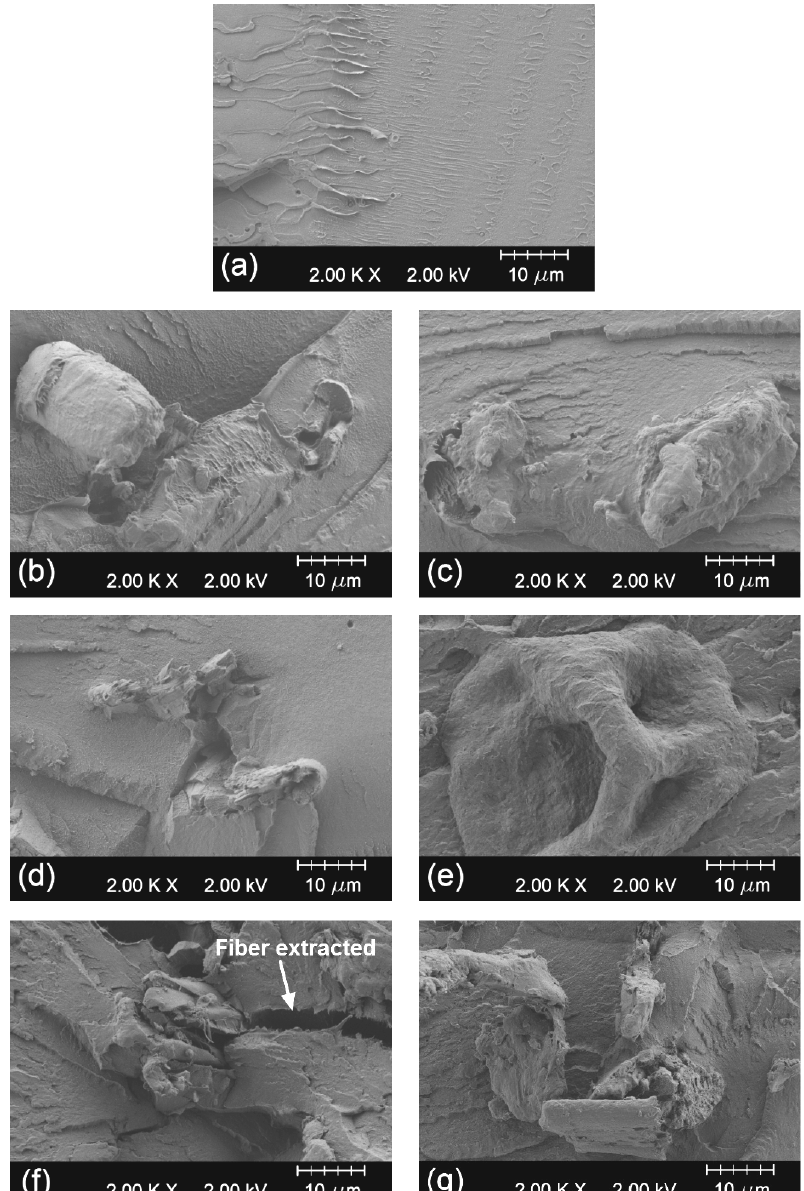
Figure 2. Field emission scanning electron microscopy (FESEM) images corresponding to the surface fractures of the bio-based polyethylene terephthalate (bio-PET)/recycled cotton fiber (RCF) composite pieces of: ( a ) Bio-PET100; ( b ) Bio-PET99/RCF01; ( c ) Bio-PET98/RCF02; ( d ) Bio-PET97/RCF03; ( e ) Bio-PET96-RCF04; ( f ) Bio-PET95/RCF05; ( g ) Bio-PET90/RCF10. Images were taken at 2000× and scale markers are 10 μ m.